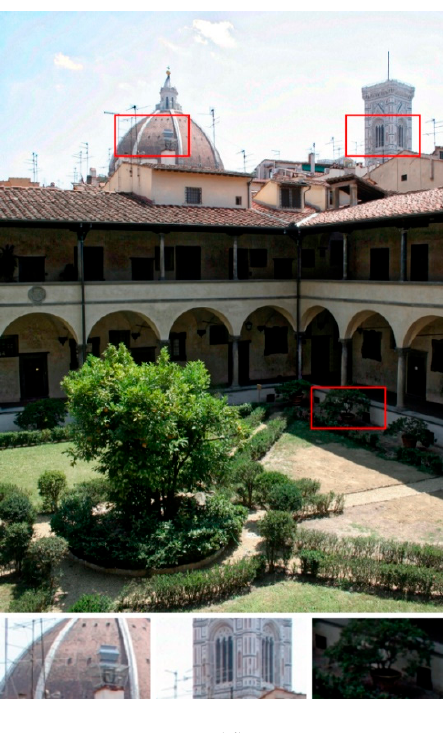
Figure 8. Results of the subjective test in terms of visual pleasantness and contrast/sharpness (average/standard deviation of the scores).